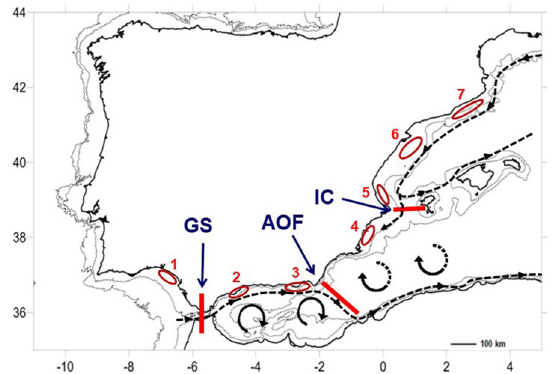
Figure 1. Sampling populations of Liocarcinus depurator in the Atlantic-Mediterranean transition. Most populations were sampled in the period 2014–2019 (see text for details). Sampling areas appear in red colour. Location numbers and acronyms are: 1. Cadiz (CADI), 2. West Alboran Sea (WALB), 3. East Alboran Sea (EALB), 4. Alacant (ALAC), 5. Valencia (VALE), 6. Ebro Delta (DELT) and 7. North Catalonia (NCAT). Dashed lines identify the main currents and gyres in the studied area. Oceanographic fronts appear as solid red lines: Gibraltar Strait (GS), Almeria-Oran Front (AOF) and Ibiza Channel (IC). This figure was prepared with the help of Surfer (Golden software Inc.) (https:// www. golde nsoft ware. com/ produ cts/